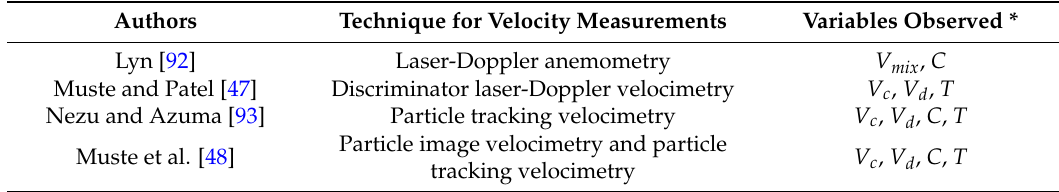
Table 6. List of datasets used in this and other studies developed by the authors (expanded from [44]). Authors Technique for Velocity Measurements Variables Observed * Lyn [92] Laser-Doppler anemometry V mix , C Muste and Patel [47] Discriminator laser-Doppler velocimetry V c , V d , T Nezu and Azuma [93] Particle tracking velocimetry V c , V d , C , T Particle image velocimetry and particle Muste et al. [48] tracking